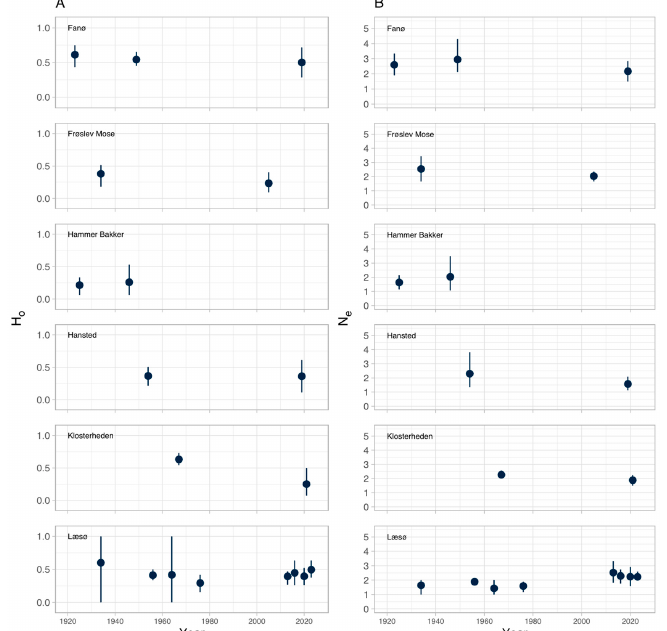
Figure 8. Change in measures of genetic diversity over time in six populations. The four contemporary Læsø populations were all sampled in 2018 but were scattered on the x-axis for visibility. The species is extinct at both Hammer Bakker and Frøslev Mose. ( A ) Observed heterozygosity, ( B ) effective number of alleles.